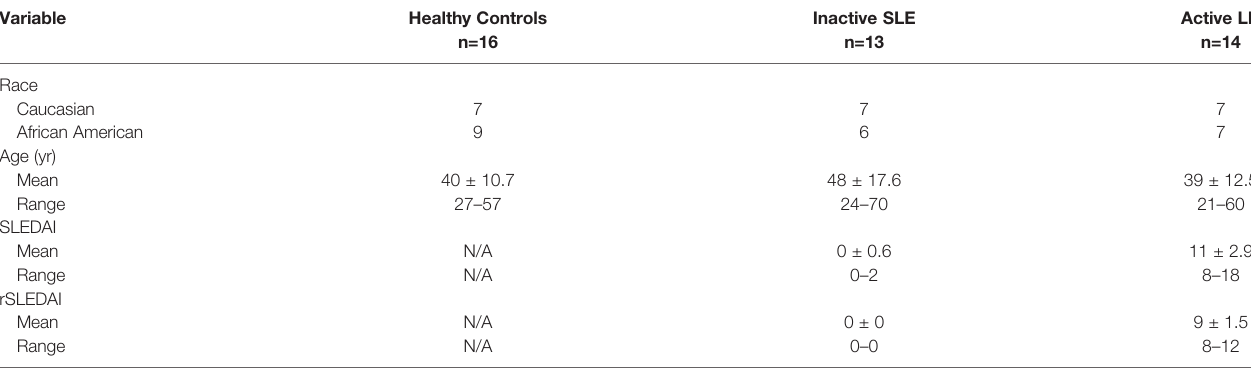
TABLE 1 | Demographic and clinical characteristic of the primary validation